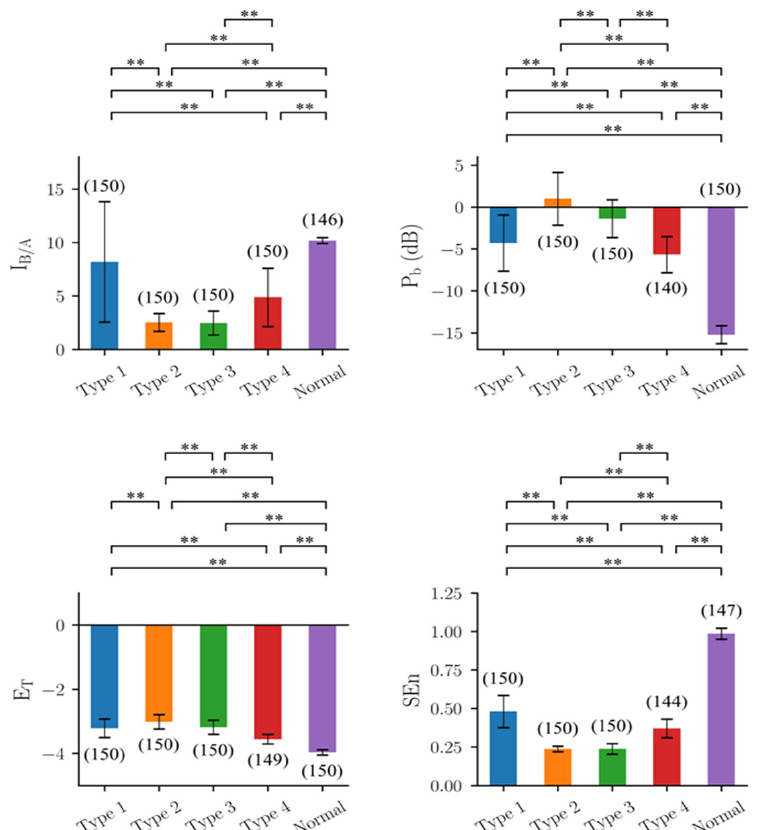
Figure 2. Results of the four indicators on the EEG segments produced by the mathematical seizure model, y(t). I B/A : estimated B/A from CSCKF, P b : band power in the frequency range of 4–50 Hz, E T : Teager energy operator, and SEn: sample entropy. The colored bar shows the mean value for each group, and the error bar shows the corresponding range of ±1 standard deviation. The number within the parentheses is the number of EEG segments, where the outliers have been excluded through the 1.5 inter-quartile range rule. **: Significant difference ( p -value < 0.01) tested by multiple comparisons using non-parametric Mann–Whitney U tests with Bonferroni corrections with α =